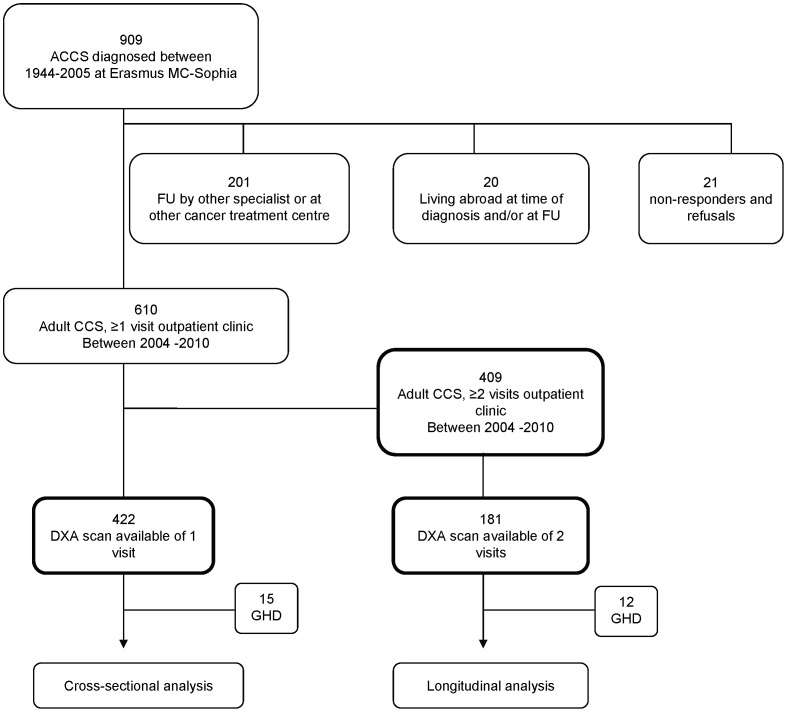
Flowchart of included survivors.
FU follow-up; CCS childhood cancer survivors; GHD Growth hormone deficiency.